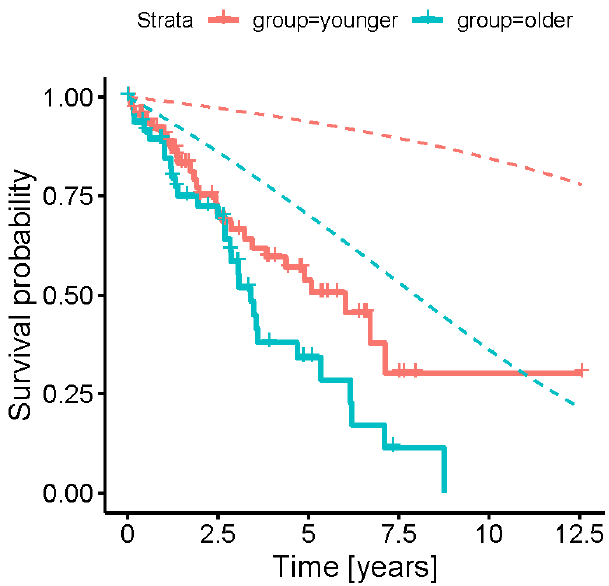
Figure 2. Kaplan–Meier plots comparing the OS in the two cohorts. The dashed lines represent the survival functions for the corresponding reference population. Both cohorts have a shorter OS than the reference population.